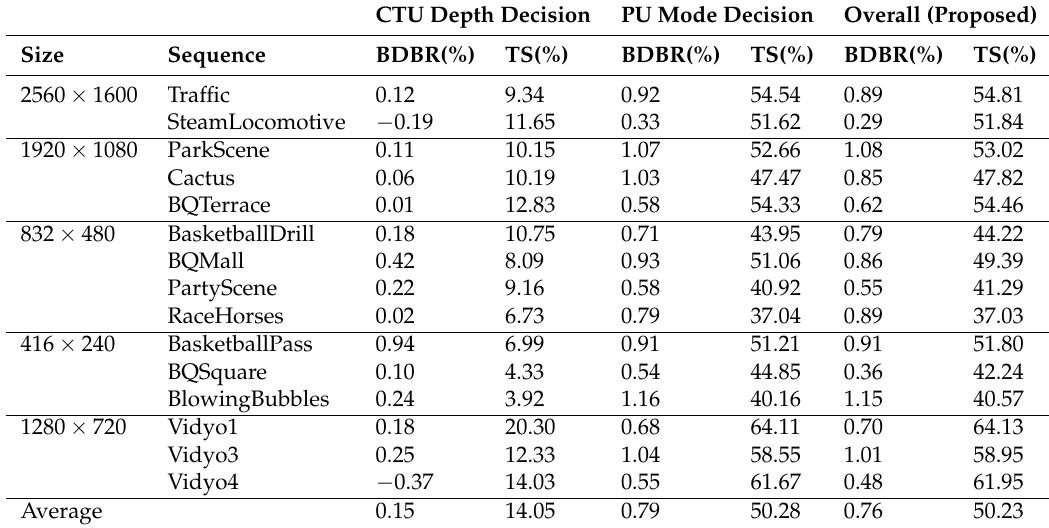
Table 4. Performance comparison of different parts of the proposed method (low delay (LD)).